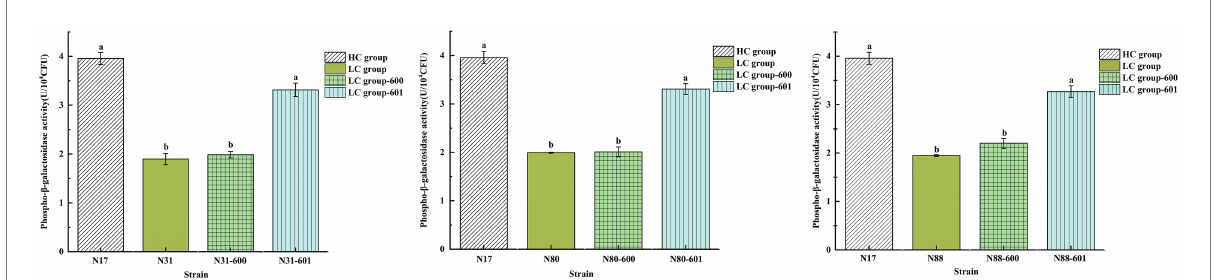
FIGURE 5 Activity of LacG (phospho- β -galactosidase) in L. casei strains. Assays were performed in triplicate and the results are presented as mean ± SD. ab Different superscript letters indicate significant differences ( p <